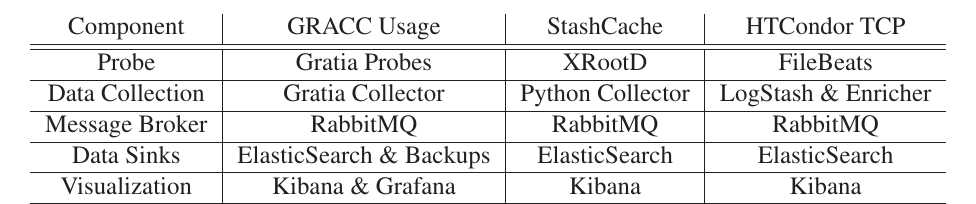
Figure 3. Example HTCondor TCP Log Message